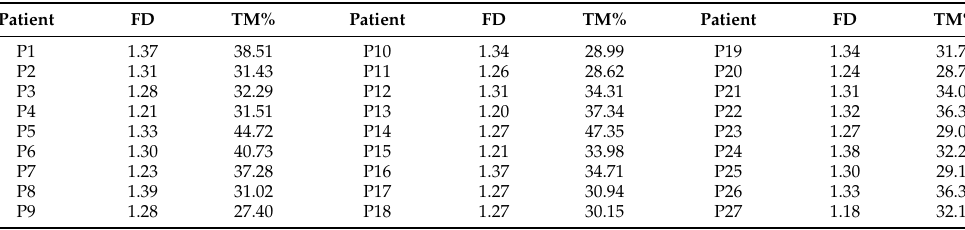
Table 3. Results of global fractal dimension (FD) [16] and percentage quantification of trabeculated myocardium